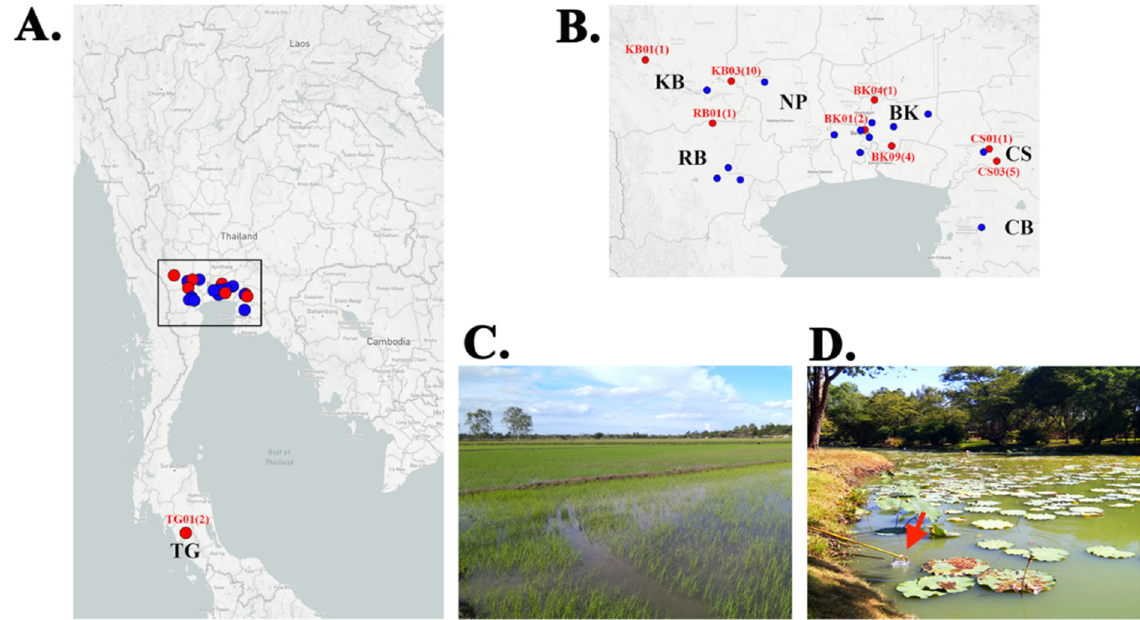
Figure 1. Geographic distribution of the P. insidiosum -positive locations in Thailand. ( A ) The map of Thailand shows 23 sampling locations (i.e., zoo, public parks, rice fields, and ponds) across 7 central and southern provinces of Thailand, which include Bangkok (BK; 10 locations: BK01-10), Chonburi (CB; 1 location: CB01), Chachoengsao (CS; 3 locations: CS01-03), Nakhon Pathom (NP; 1 location: NP01), Kanchanaburi (KB; 3 locations: KB01-03), Ratchaburi (RB; 4 locations: RB01-04), and Trang (TG; 1 location: TG01). ( B ) An enlarged map demonstrates the sampling locations shown in the box in Figure 1A. The P. insidiosum -positive locations (i.e., KB01, BK01, and CS01) are indicated in red. The number in each parenthesis is the number of P. insidiosum strain(s) successfully isolated from the corresponding location. ( C ) The location KB03 is a rice field, where 10 strains of P. insidiosum (strain IDs: KCB01–CB10) have been isolated. ( D ) The location BK09 is a pond in a public park in Bangkok, in which 4 strains of P. insidiosum (strain IDs: RM9-02–RM9-05) have been recovered (the arrow indicates a clean disposable plastic bucket used to collect water sample).